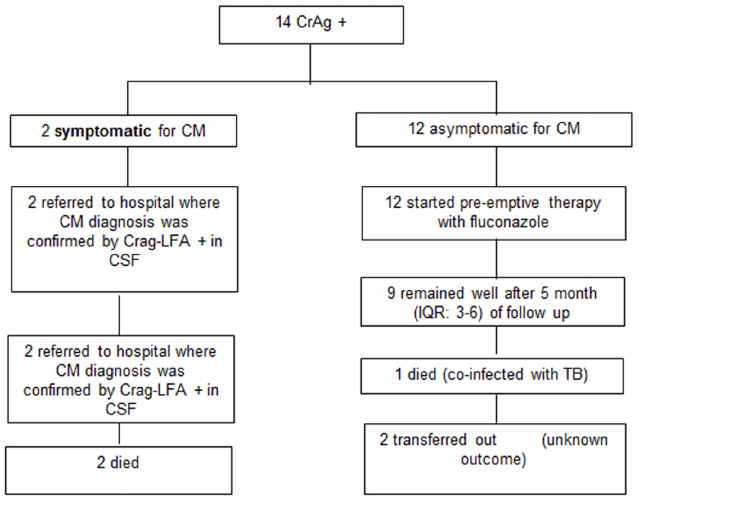
Fig 2. Outcomes among patients who tested positive for